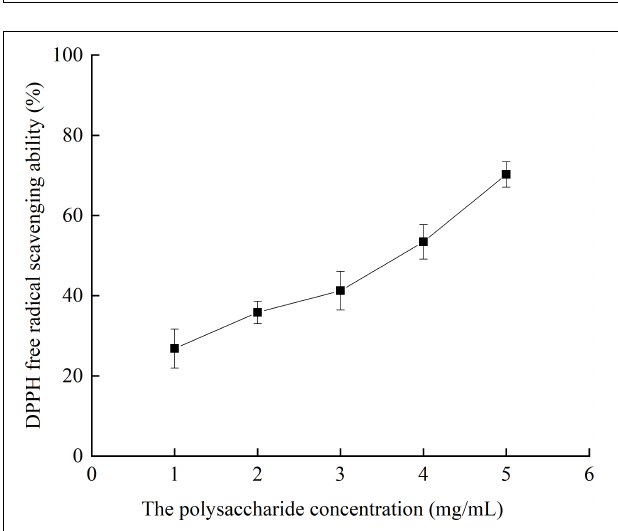
FIGURE 10 | Superoxide anion radical scavenging ability of crude polysaccharides from fruiting bodies with different concentrations in